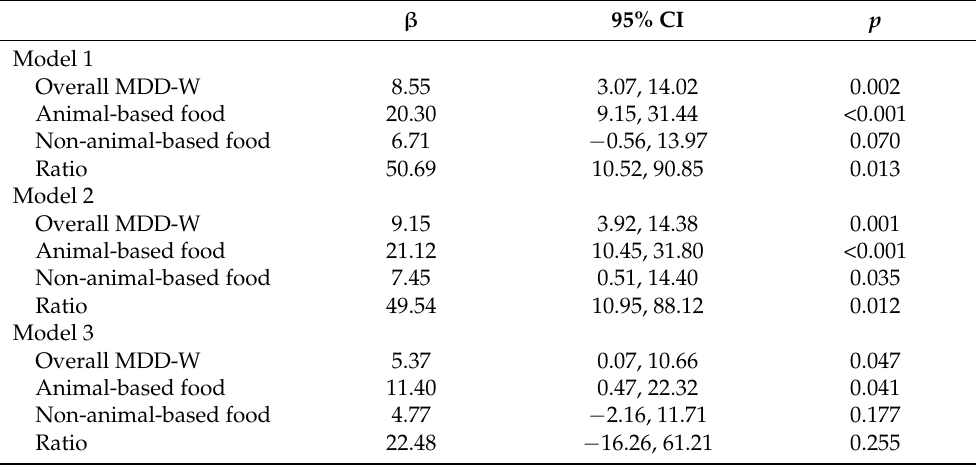
Table 2. Association between MDD-W score and neonatal birth weight by linear regression ( n = 6805). β